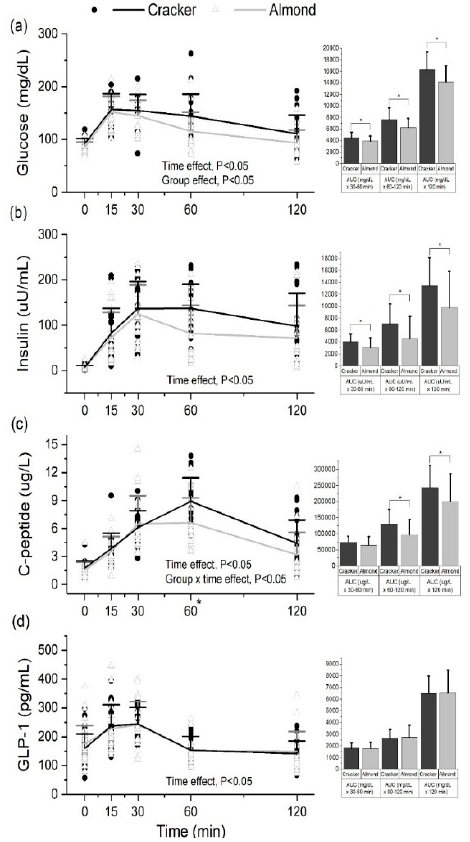
Figure 4. Serum ( a ) glucose, ( b ) insulin, ( c ) C-peptide and ( d ) GLP-1 profiles at 0, 15, 30, 60 and 120 min of an oral glucose tolerance test (OGTT) in the cracker and almond groups at week 8 of the intervention. Values are individual data points representing each participant at each time point. Means ± SDs of the 2 snack groups at each time point are also plotted. Analysis was conducted using a linear mixed effects model with time as within-subject factor and snack group as between-subject factor. Glucose, insulin, C-peptide and GLP-1 values were transformed prior to analysis using Johnson’s family of transformations. Area under the curves (Means ± SDs) are displayed adjacent to the respective OGTT profiles. Analysis was conducted using a Kruskal-Wallis test with snack group as between-subject